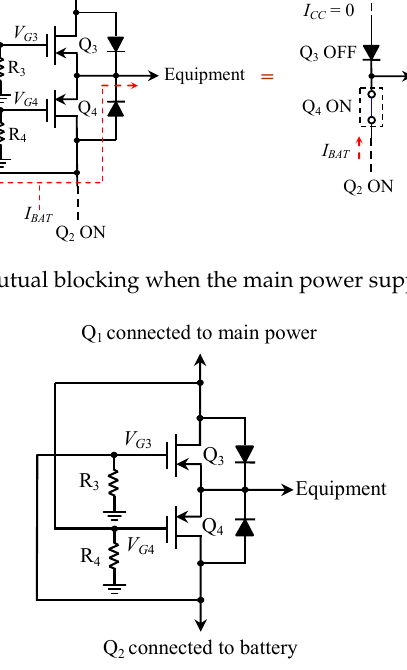
Figure 7. Mutual blocking circuit. Figure 9. Mutual blocking